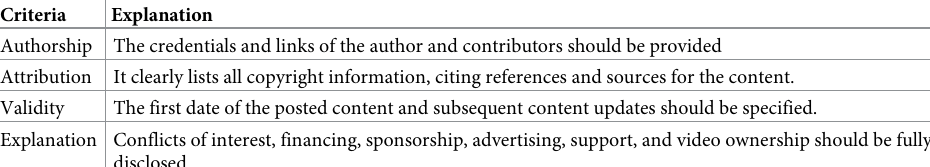
Table 1. The Journal of American Medical Association (JAMA) comparison